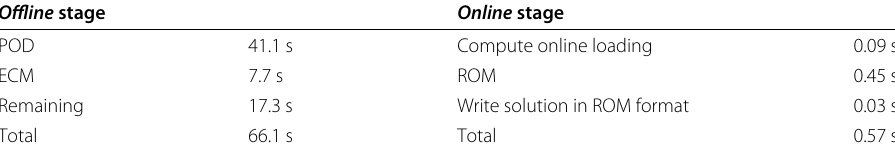
Table3 Industrial application (durations for the offline and online stages) Offline stage